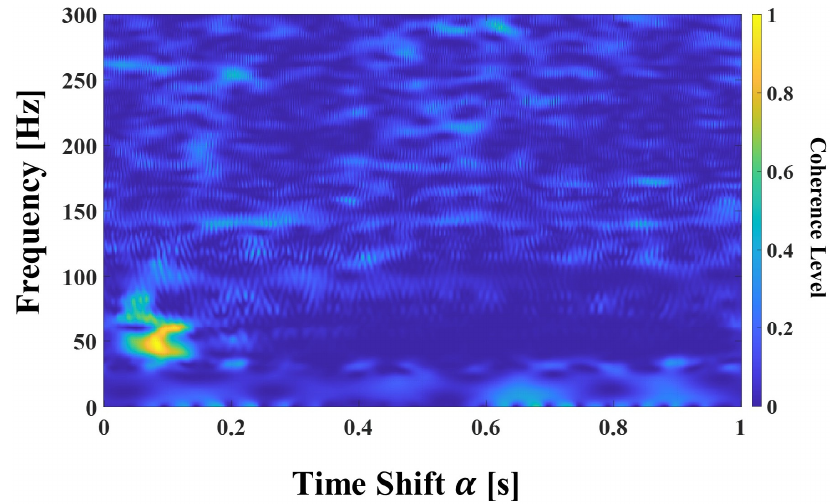
Figure 16. Time-shift coherence results using measured signals.